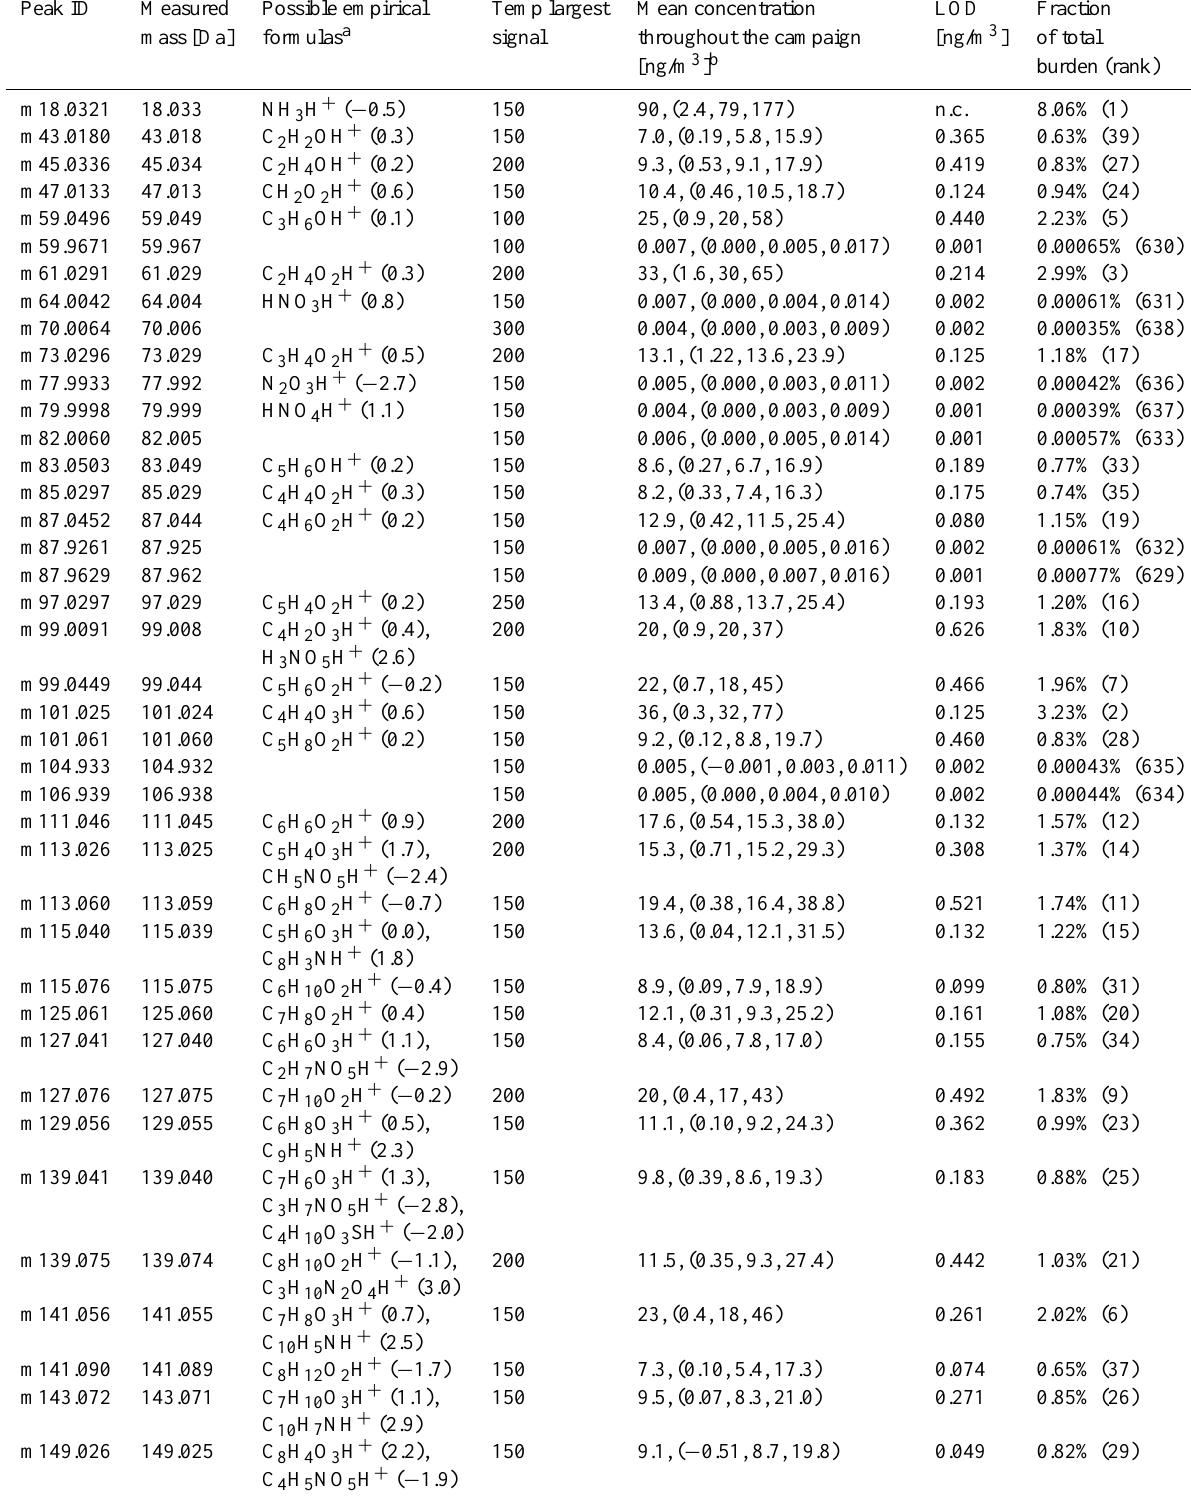
Table 1. Basic information on the 40 most abundant and 10 least abundant aerosol compounds. A full list of all 638 detected compounds is given in the supplemental